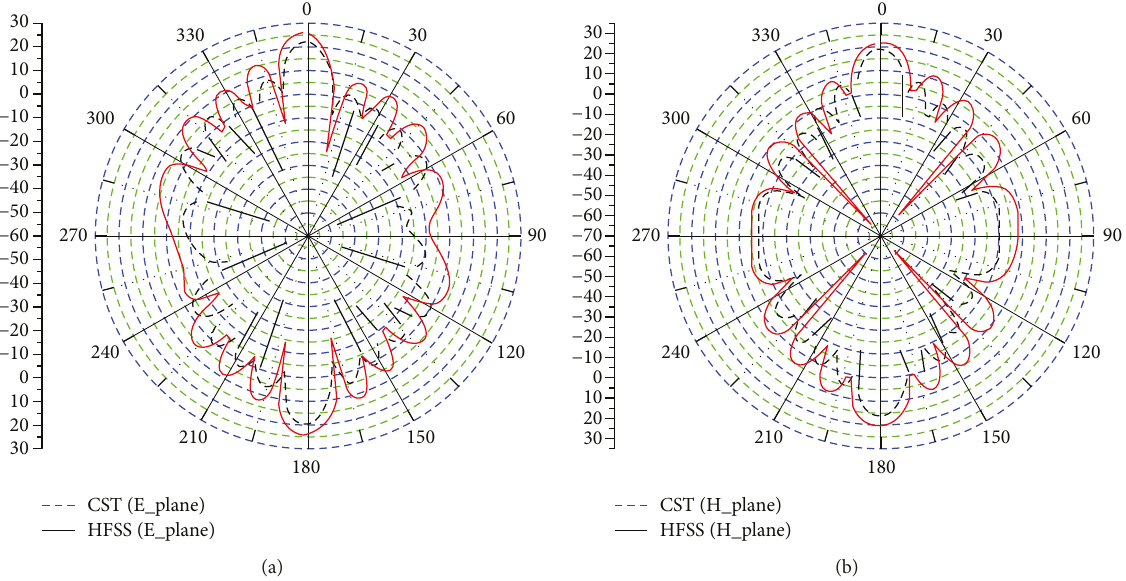
Figure 12: Comparison of 2D gain radiation pattern of the proposed array antennas. (a) E_plane in CST and HFSS and (b): H_plane in CST and HFSS.